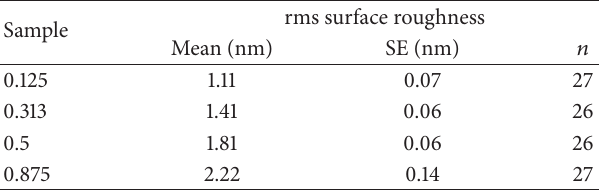
Table 1: rms surface roughness values measured on 30 × 30 nm 2